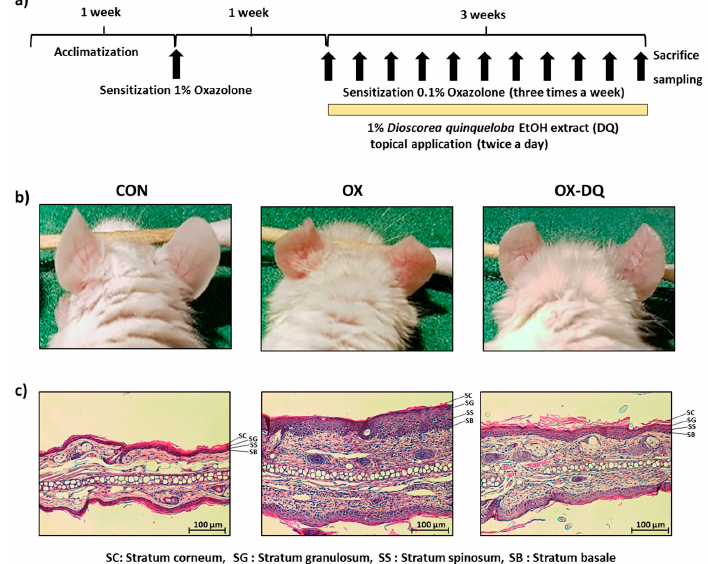
Figure 1. Effects of DQ on the development of oxazolone-induced AD-like symptoms in BALB/c mouse ears and histopathological analysis. CON: control group, OX: oxazolone-treated group, OX-DQ: oxazolone and 1% D. quinqueloba EtOH extract-treated group. ( a ) Schematic representation of the experiment; ( b ) Clinical features of AD-like skin lesions; ( c ) Histopathological features of skin